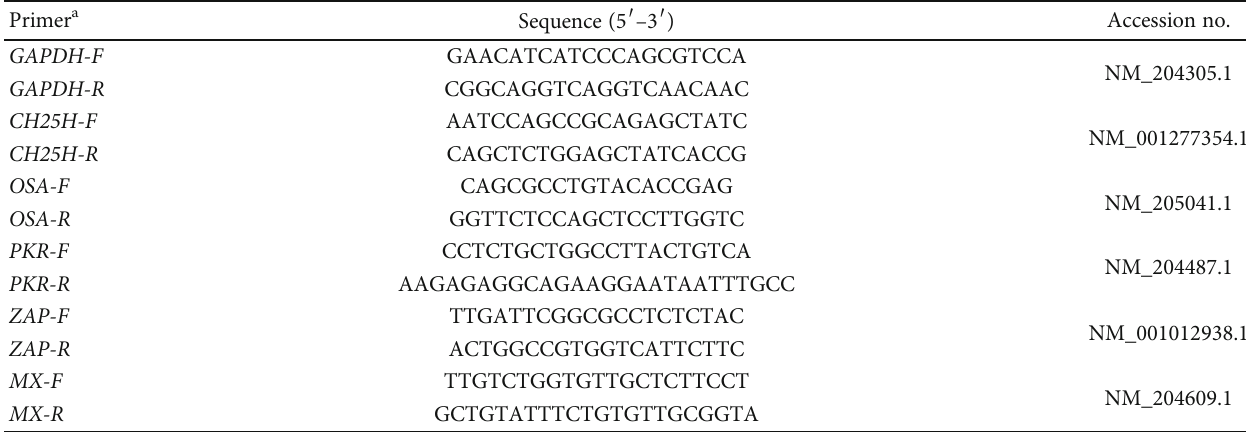
Table 3: The primers used for the